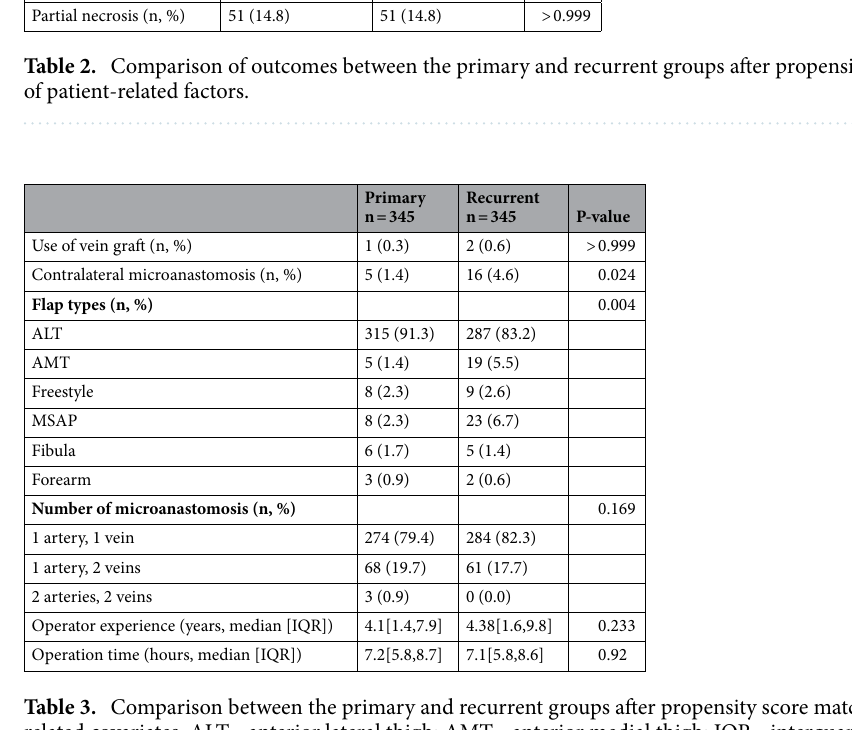
Table 3. Comparison between the primary and recurrent groups after propensity score matching of patient- related covariates. ALT = anterior lateral thigh; AMT = anterior medial thigh; IQR = interquartile range; MSAP = medial sural artery